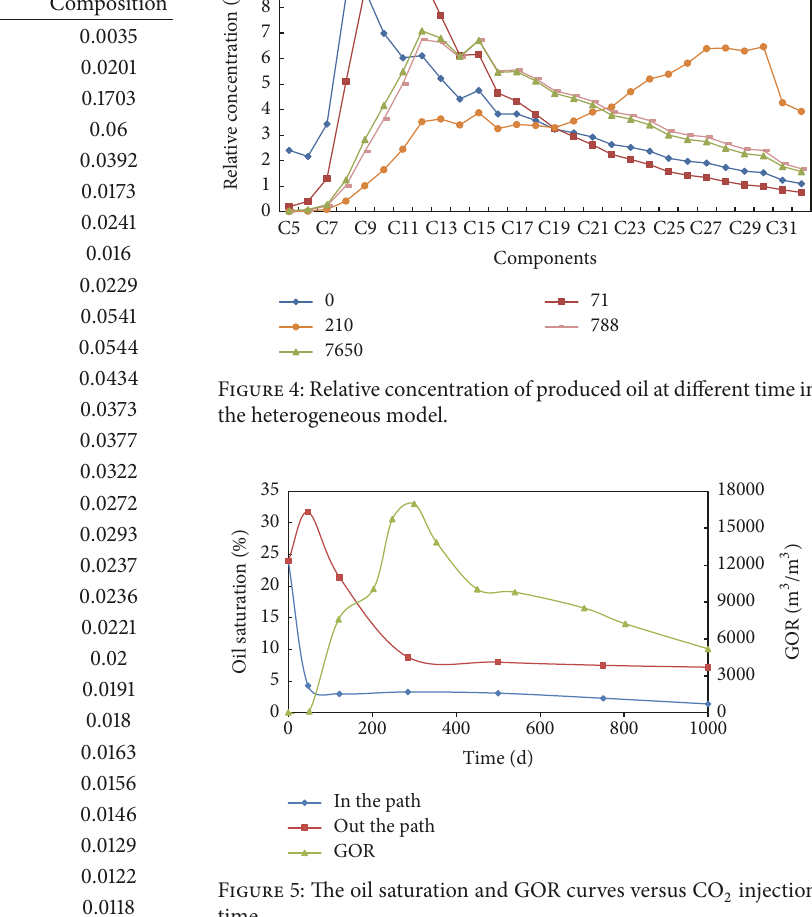
Table 2: Oil component compositions in the models.